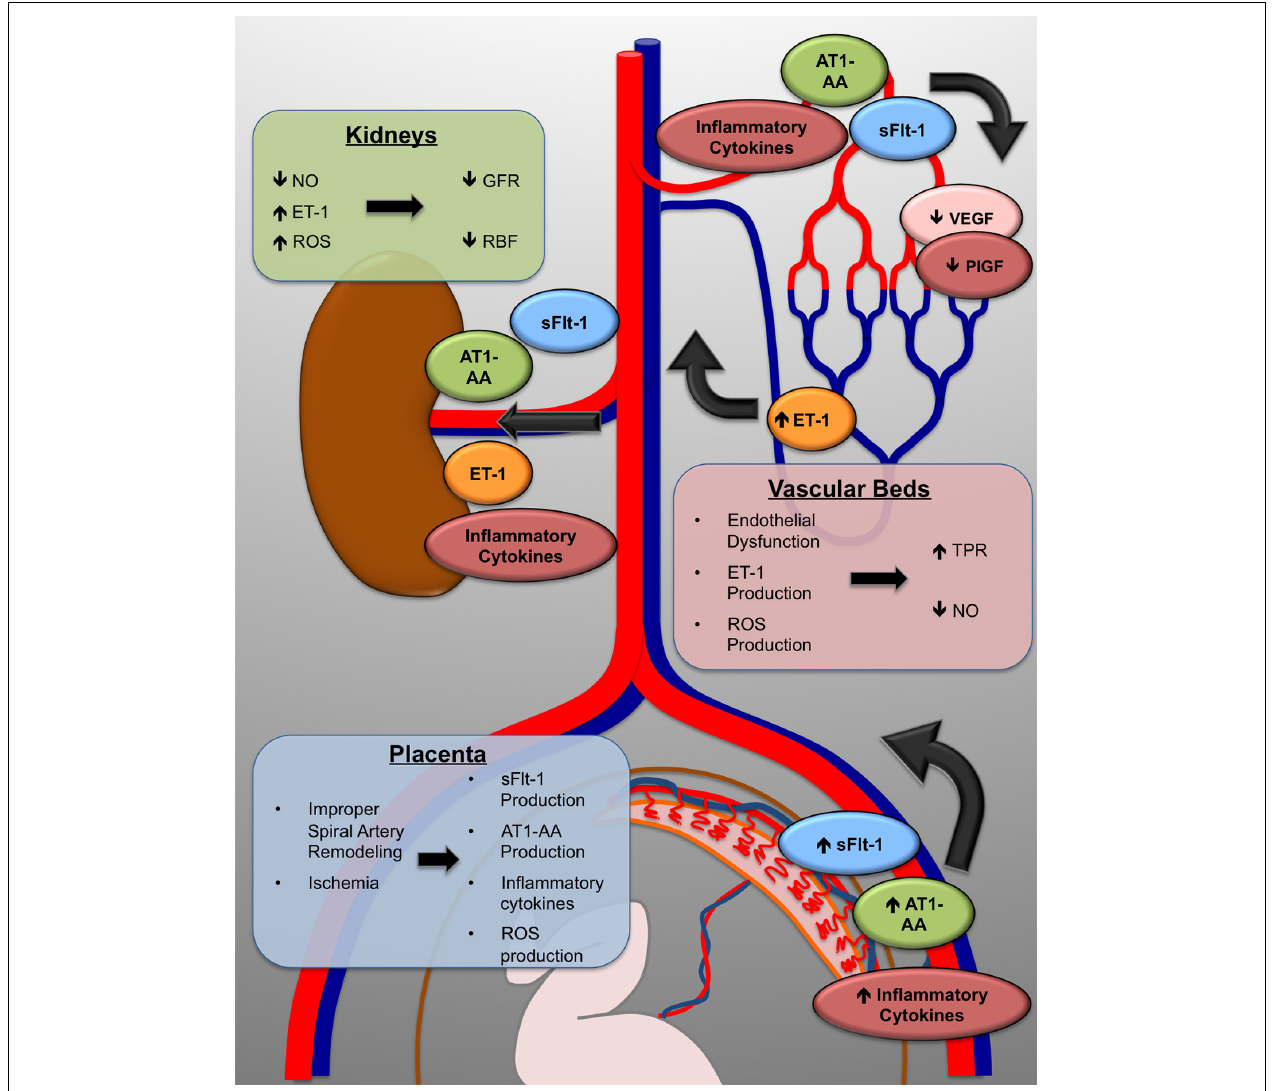
including that in the kidneys, is exposed to decreased VEGF signaling and inflammatory mechanisms which cause endothelial dysfunction, marked by overproduction of the vasoconstrictor endothelin-1 (ET-1). In the kidneys, total peripheral resistance (TPR) increases, renal blood flow (RBF) and glomerular filtration rate (GFR) decrease, and maternal hypertension is the end